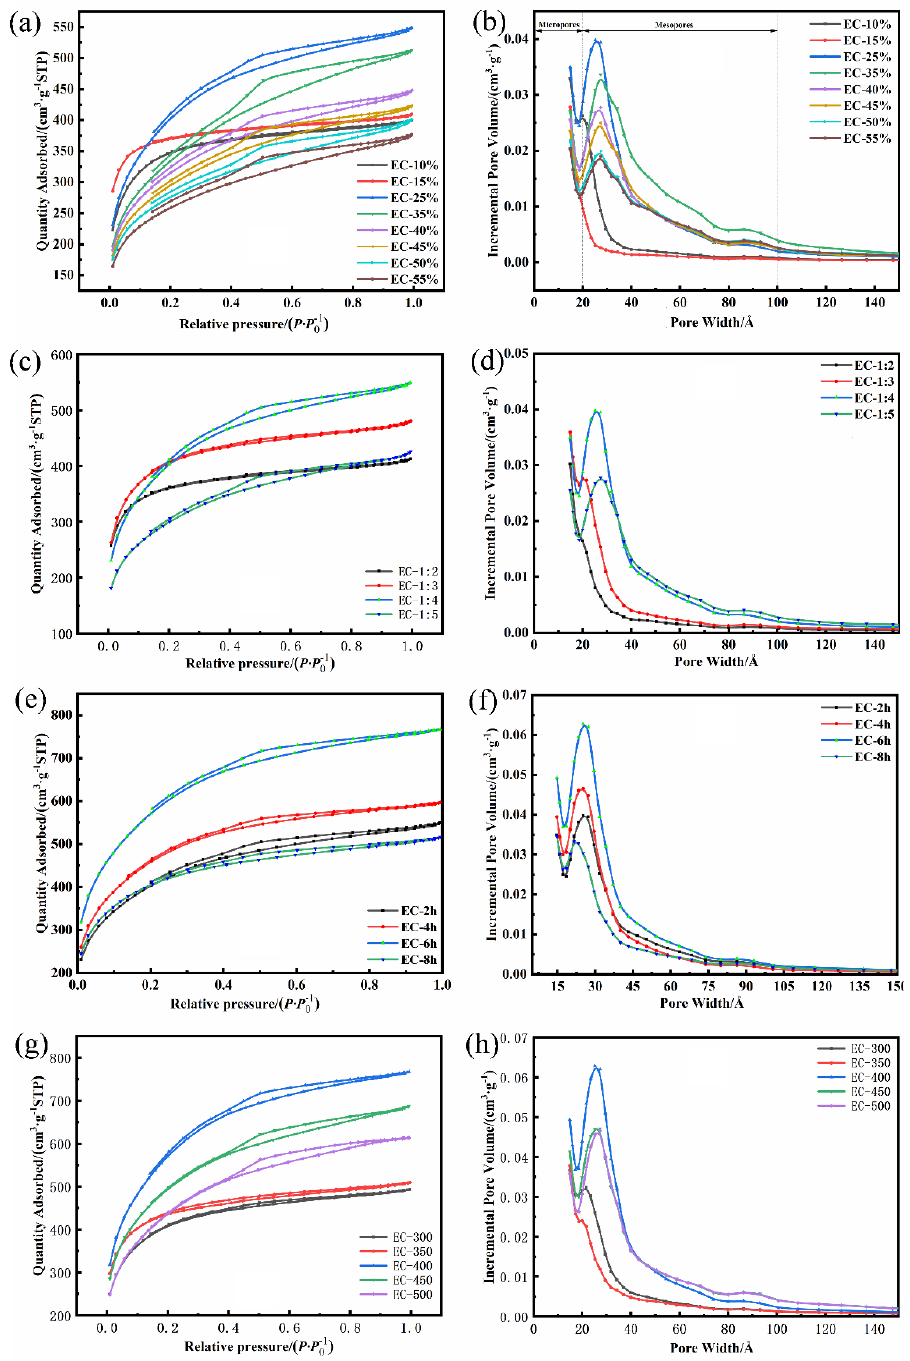
Figure 1. ( a , c , e , g ) Nitrogen adsorption-desorption curves of ECs; ( b , d , f , h ) Pore size distribution curves of ECs. curves of